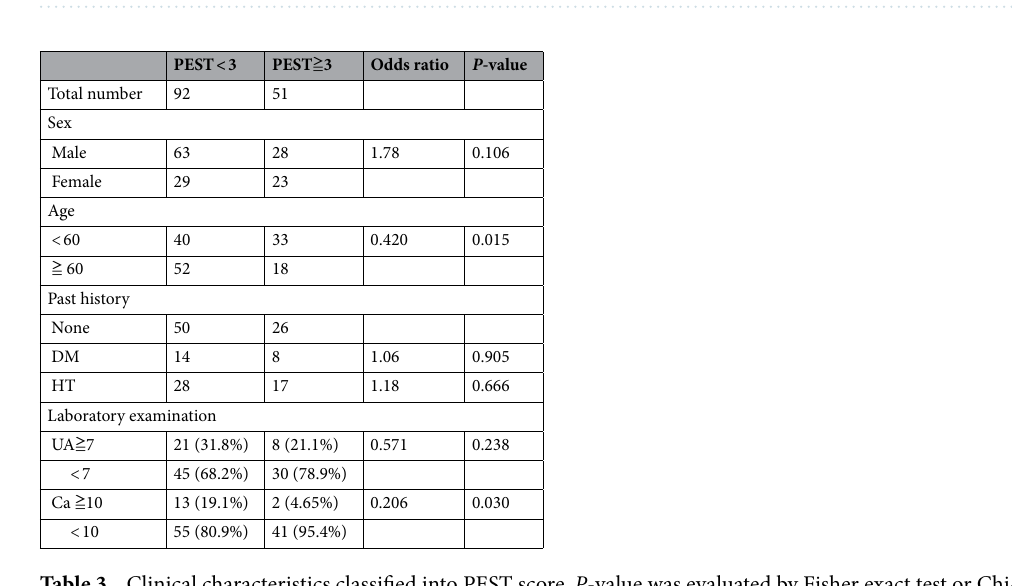
Figure 1. The results of PEST questionnaire. The different distribution of 5 questions in PEST questionnaire was analyzed between PEST score high and low patients.